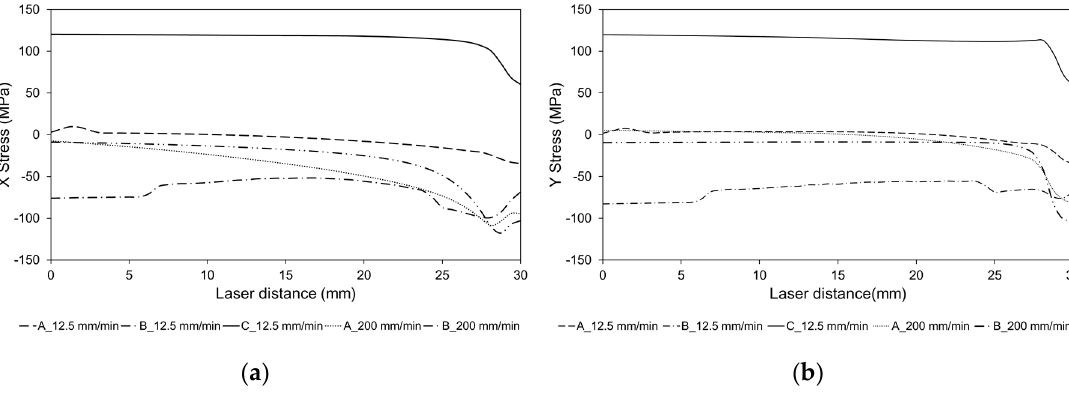
Figure 8. Distributions of stresses along the parallel (X) and perpendicular (Y) directions to laser scan direction with the laser track distance for the different test cases at the end of the process (see Tables 3 and 4): ( a ) Normal X stress; ( b ) Normal Y stress. The profiles have been acquired at the end of the process when the laser focal point is at the limit of the path. Coatings 2018 , 8 , x FOR PEER REVIEW